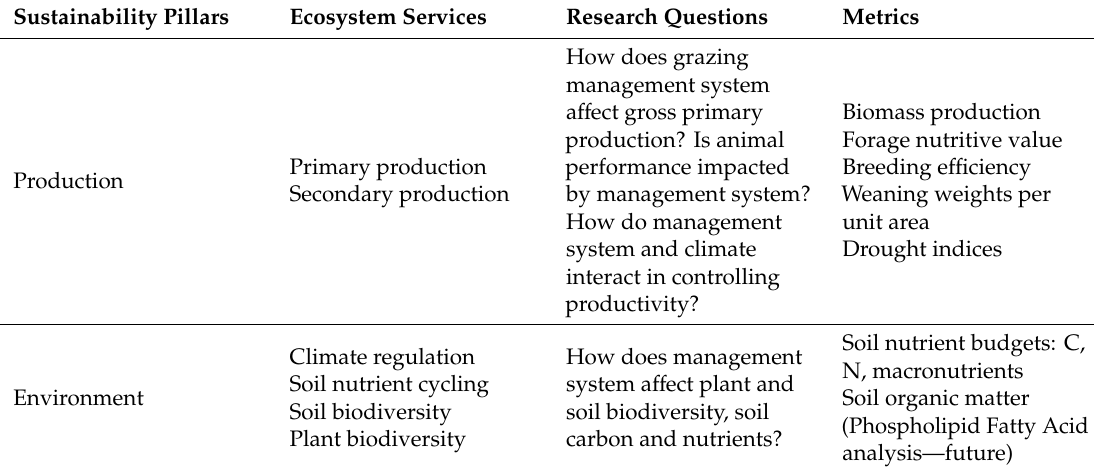
Table 1. Research questions and metrics to address ecosystem services of alternate grazing